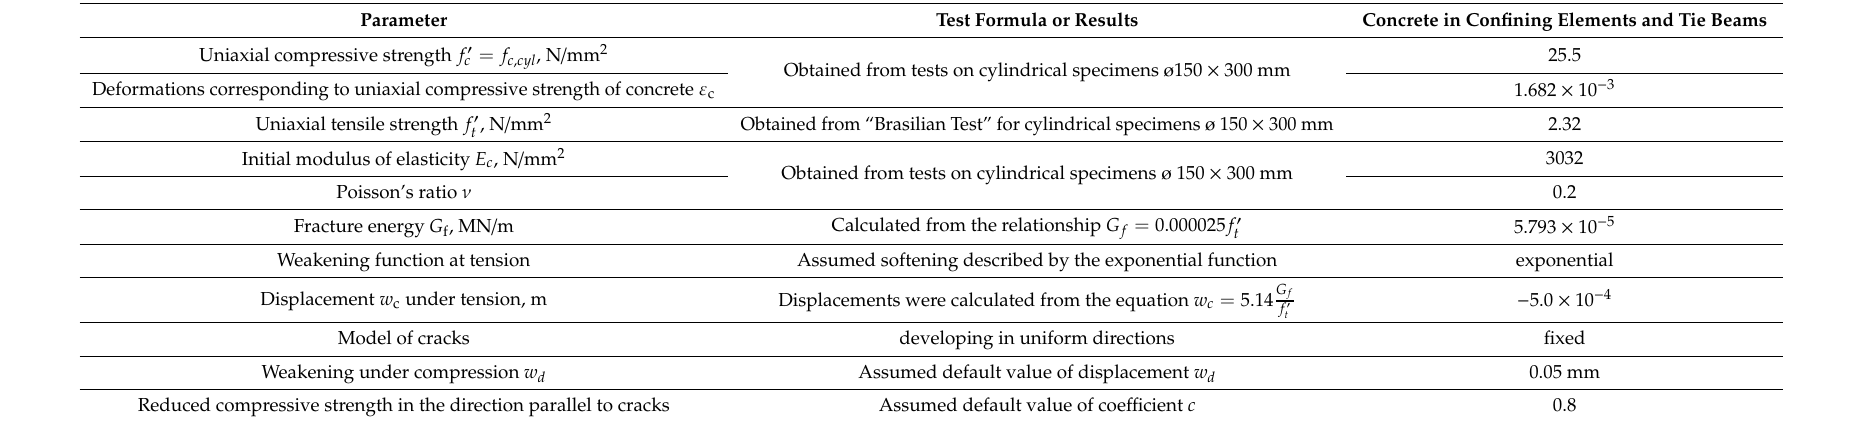
Table 3. Parameters of the elastic-based degradation model used in